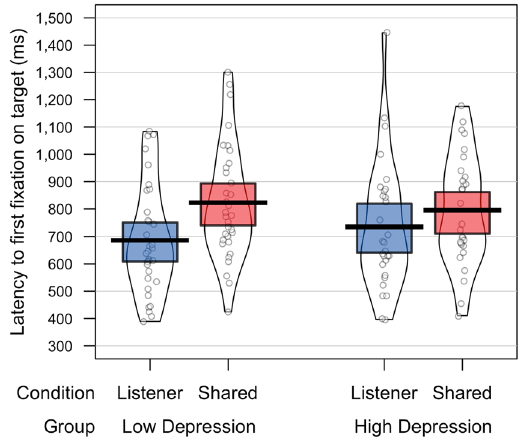
Figure 4. Mean latency to first fixate the target object for each condition and depression